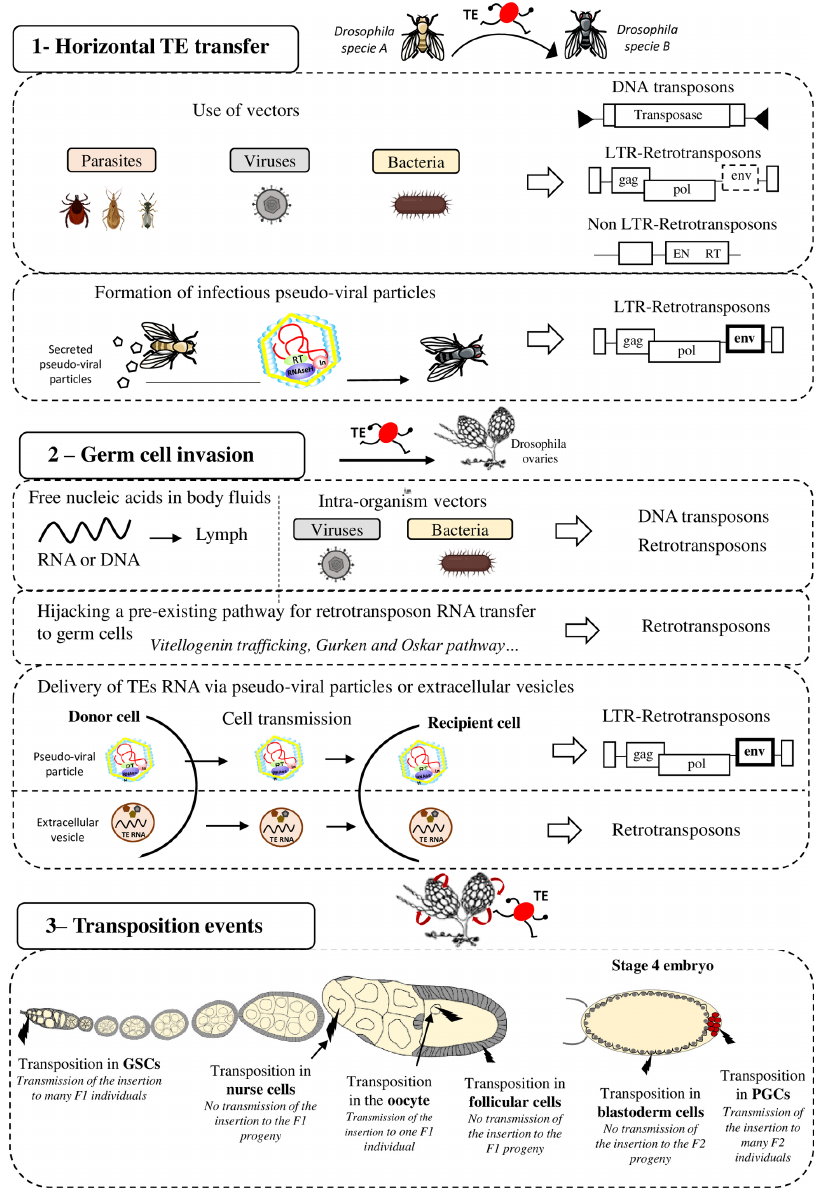
Figure 1. Strategies for effective spreading of transposable elements in the Drosophila genome. Transposable elements (TE), DNA transposons and LTR and non-LTR retrotransposons, can colonize “naive” genomes through horizontal transfer ( panel 1 ). This may occur via vectors (e.g., parasites, viruses, and bacteria) that transfer genetic content from one organism to another. It has also been proposed that LTR retrotransposons (ERV) can form pseudo-viral particles with infectious properties. Then, invading TEs need to reach the host’s germline ( panel 2 ) for vertical transmission to the progeny. To this end, TE sequences (excised DNA or RNA for retrotransposons) might circulate in the blood or be transported to germ cells by intra-organism vectors (viruses, bacteria). Retrotransposons can hijack pre-existing cell pathways, such as the vitellogenin trafficking ( ZAM ), Gurken ( I-element ) or Oskar (TAHRE ) pathways, to transfer their RNA to germ cells. LTR-retrotransposons (ERV), through the formation of infectious pseudo-viral particles, might also be transferred between cells and/or circulate through extracellular fluids to reach the host’s germline. Extracellular vesicles have also been proposed to be efficient vectors for transferring TEs between host cells The last step for efficient invasion requires transposition in germ cells (panel 3) that allows or not (in function of the cell type) the TE transmission and propagation in the specie. GSC = Germinal Stem Cells, PGC = Primordial Germ Cells.